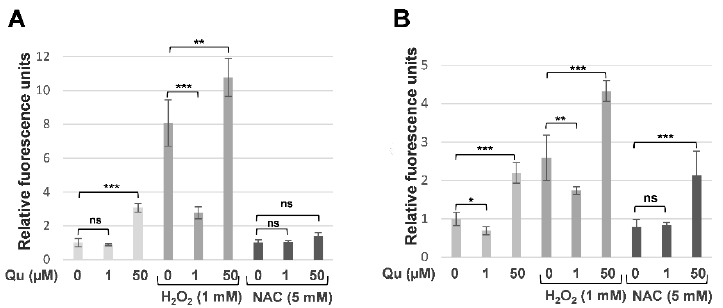
Figure 5. Intracellular ROS activation in 2D and 3D human melanoma cells, after quercetin treatment. 2D cell culture ( A ) and melanoma spheroids ( B ) were treated on day 4 with 0, 1, or 50 µM of quercetin alone or together with 1 mM of H 2 O 2 or 5 mM of NAC for 6 h, with the pro- and/or anti-oxidative activity measured using 2′,7′-Dichlorofluorescin diacetate (DCFDA) (D6883-50MG, Sigma-Aldrich, St. Louis, MO, USA). The experiments were performed three times in sextuplicate. The data are normalized to the equivalent solute concentration and to the non-treated cells and are expressed as the mean ± S.D. The p- values are expressed as * p < 0.05, ** p < 0.01, and *** p < 0.001, compared to the control (0 µM).